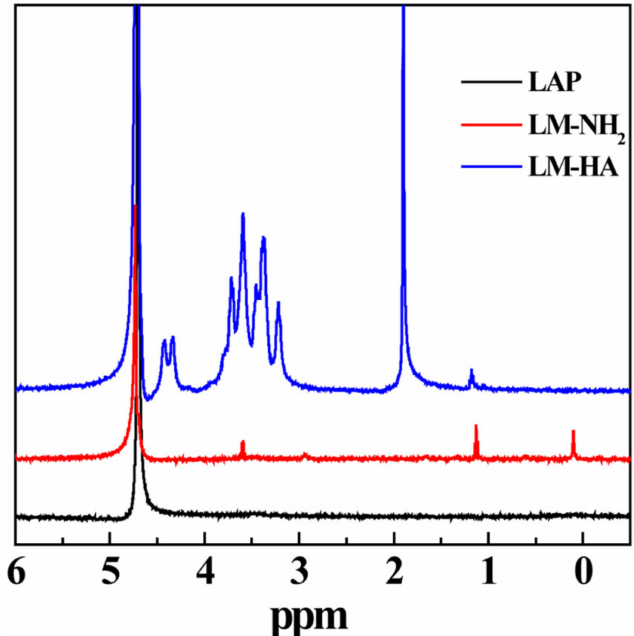
Figure 1. 1 H NMR spectra of laponite nanodisks (LAP), LM-NH 2 and LM-HA.